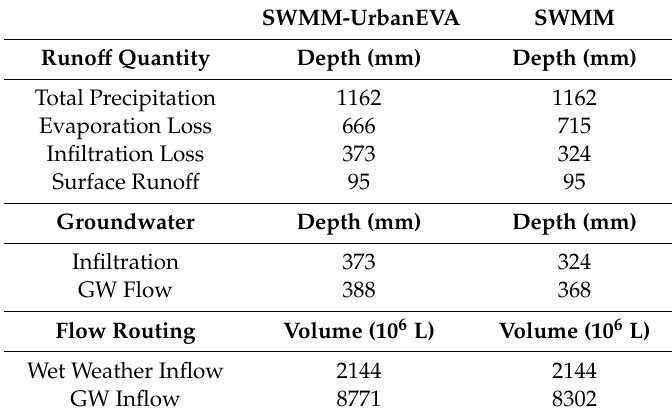
Table 7. Extract from the SWMM status report for the simulation period 1 December 2015–31 July 2017 (entire model area).